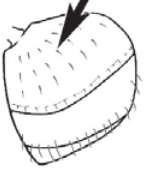
– Clypeus generally rounded or flattened towards its anterior margin, not 80 Appressed setae on the gaster in all workers very small and inconspicuous when gaster is moderately distended, separated from one another by at least their own length, these appressed setae also inconspicuous on mesosoma and never long and silvery; mesosoma glabrous in minor worker or with one or a few flexuous, erect setae; node of minor worker often squamiform; most commonly cuticle shining or even glossy with vestigial or weak shagreenation ............................